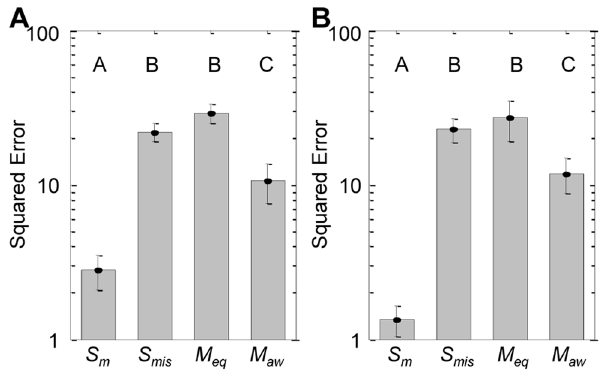
Figure 4. Summary of target tracking performances for the simulated case studies. (A) Summary of experiments involving realistic control reagents sanguinarine and U0126. (B) Summary of experiments involving hypothetical reagents aZAP and iZAP. Target tracking performance is measured by the squared error between target profiles and controlled plants. Data shown are mean 6 standard error between matched ( S m , n=30) and mismatched ( S mis , n=60) single- model controllers, M eq (n=30) and M aw (n=30). Group letters denote statistically significant differences between groups (p , 0.05) as calcu- lated by one-way ANOVA with Tukey multiple comparisons test